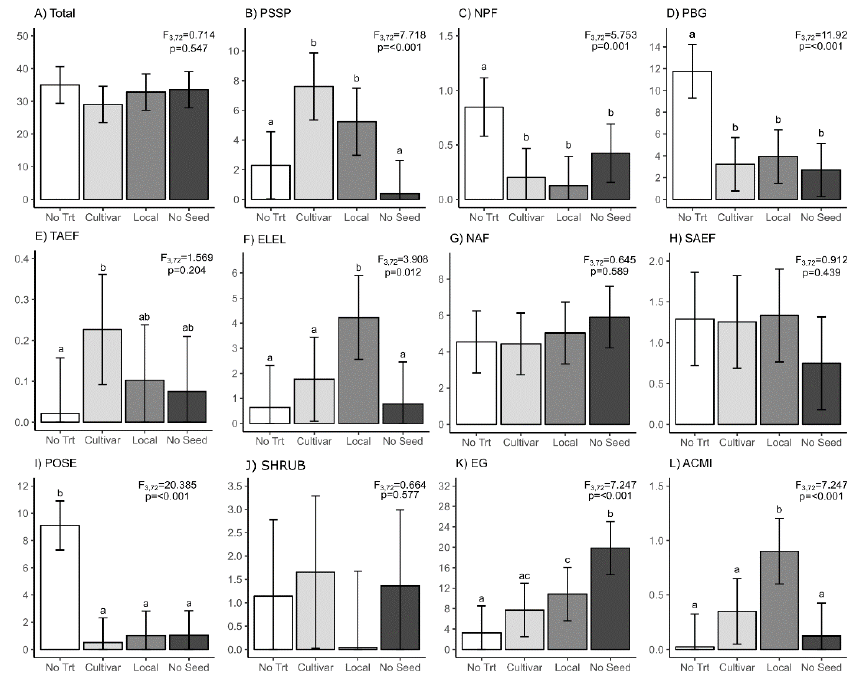
Figure 4. Slash pile functional group mean cover (%) by seeding treatment in 2017: least square means, 95% confidence intervals and ANOVA p -values. Lowercase letters denote significance among treatments (post-hoc contrasts, p < 0.10). ( A ) Total, Total plant cover; ( B ) PSSP, Psuedoroegneria spicata ; ( C ) NPF, Perennial Forbs; ( D ) PBG, Perennial large bunchgrasses; ( E ) TAEF, Tall annual exotic forbs; ( F ) ELEL, Elymus elymoides ; ( G ) NAF, Native annuals; ( H ) SAEF, Small annual exotic forbs; ( I ) POSE, Shallow, early season grass; ( J ) SHRUB, Shrubs; ( K ) EG, Exotic grasses; ( L ) ACMI, Achillea millefolium.